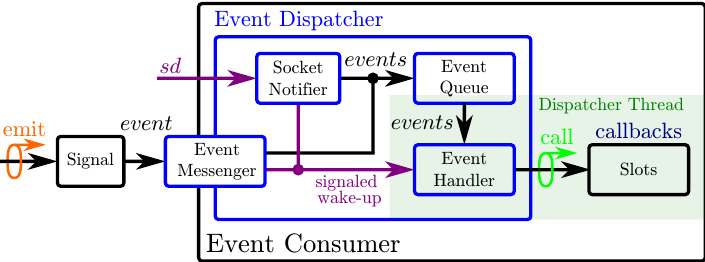
Figure 5. An event dispatcher combined with the signal-slot principle facilitates the connection of event generators and consumers within processes; an event handler implementing the signaled-wakeup principle dispatches events on their occurrence and drives the processing of events in the event consumer; this architecture allows multi-threaded signal-slot connections and eases the development of event generators and